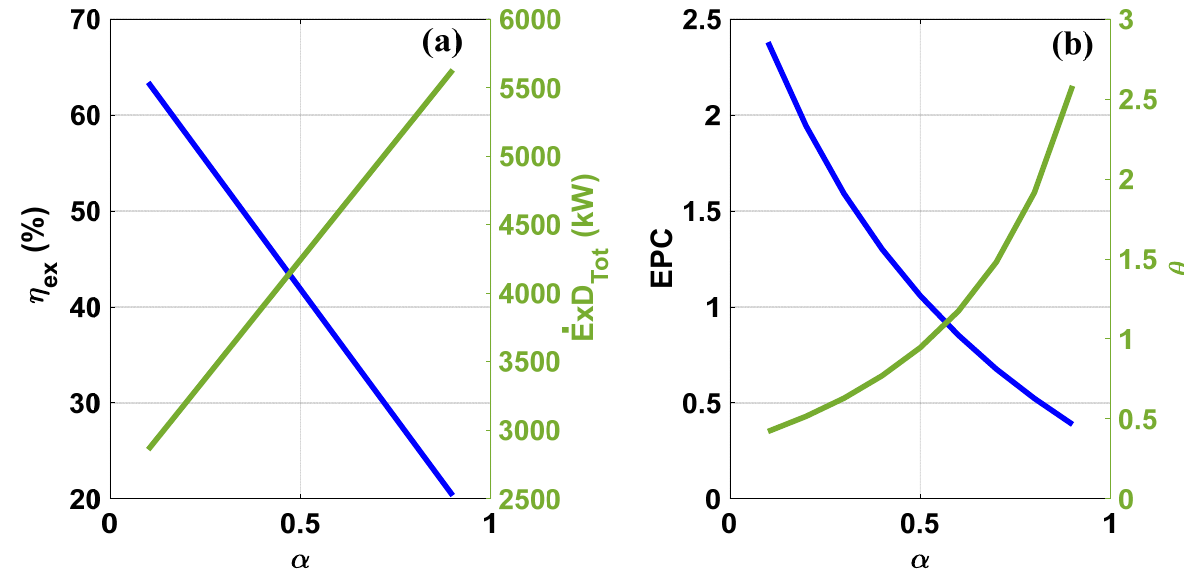
Figure 7. ( a ) Exergy efficiency and destruction variations against cooling to power flow ratio. ( b ) The exergetic performance criteria and exergo ‐ environmental impact index variations with cooling to power flow ratio.